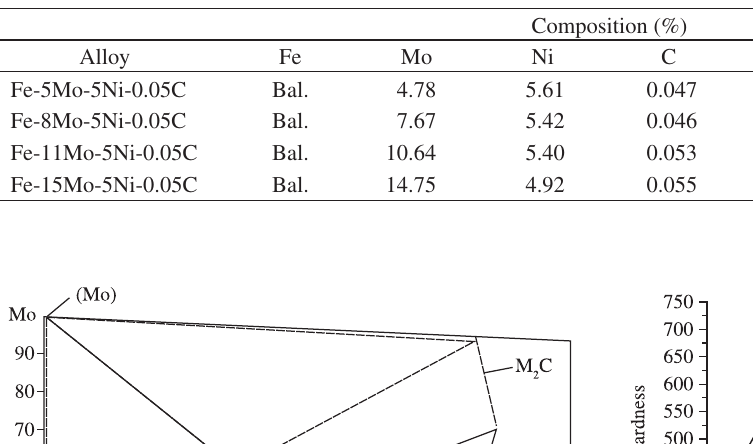
Table 2. Chemical composition of the melted ingots Alloy